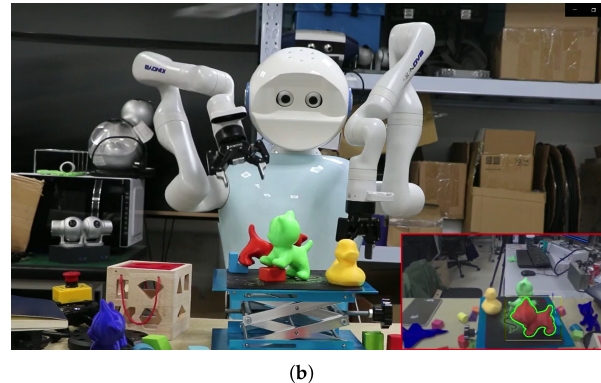
Figure 1. The intelligent robotic 6D grasping system working under different installation positions. ( a ) Robotic system is installed on the table; ( b ) robotic system is installed on the